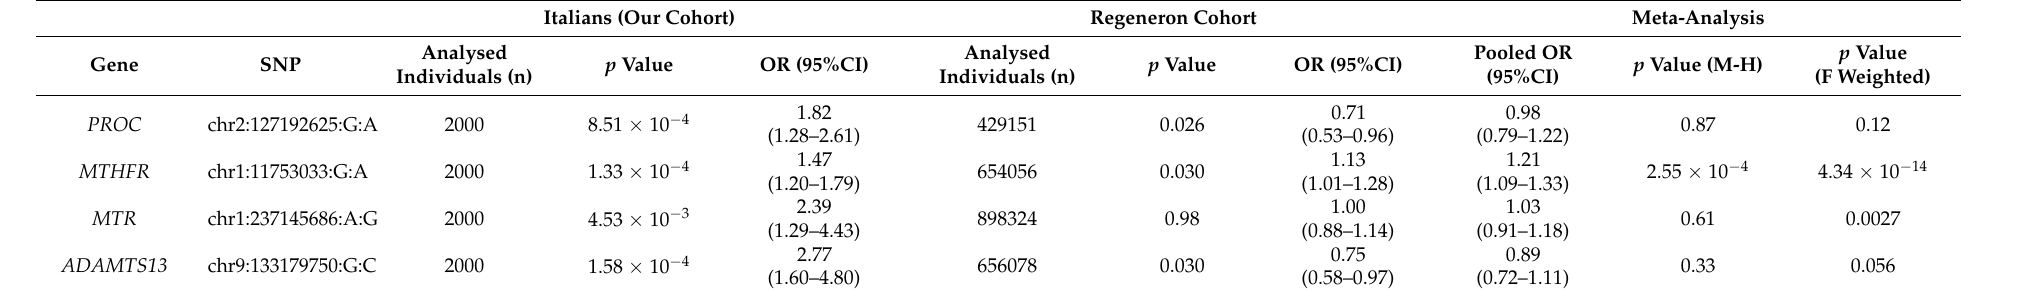
Table 4. Meta-analysis results for the four best hits mapping in the PROC , MTHFR , MTR , and ADAMTS13